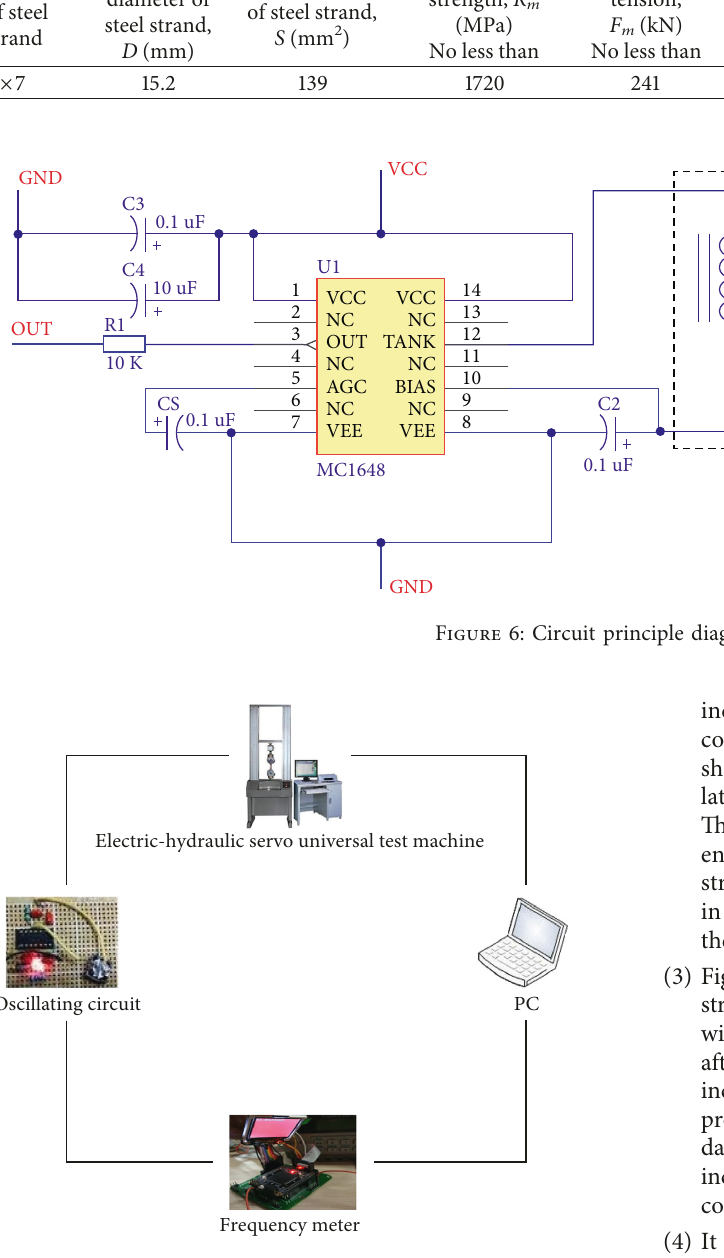
Figure 7: The experiment structure diagram.